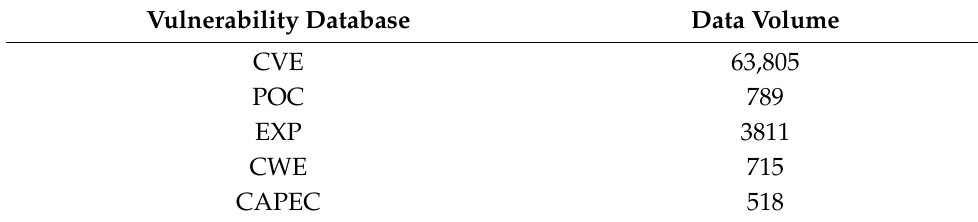
Table 15. Data volume of local vulnerability